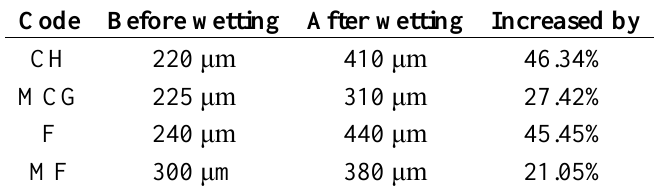
Table 3. Yarn diameter of yarns in Group 1 before and after